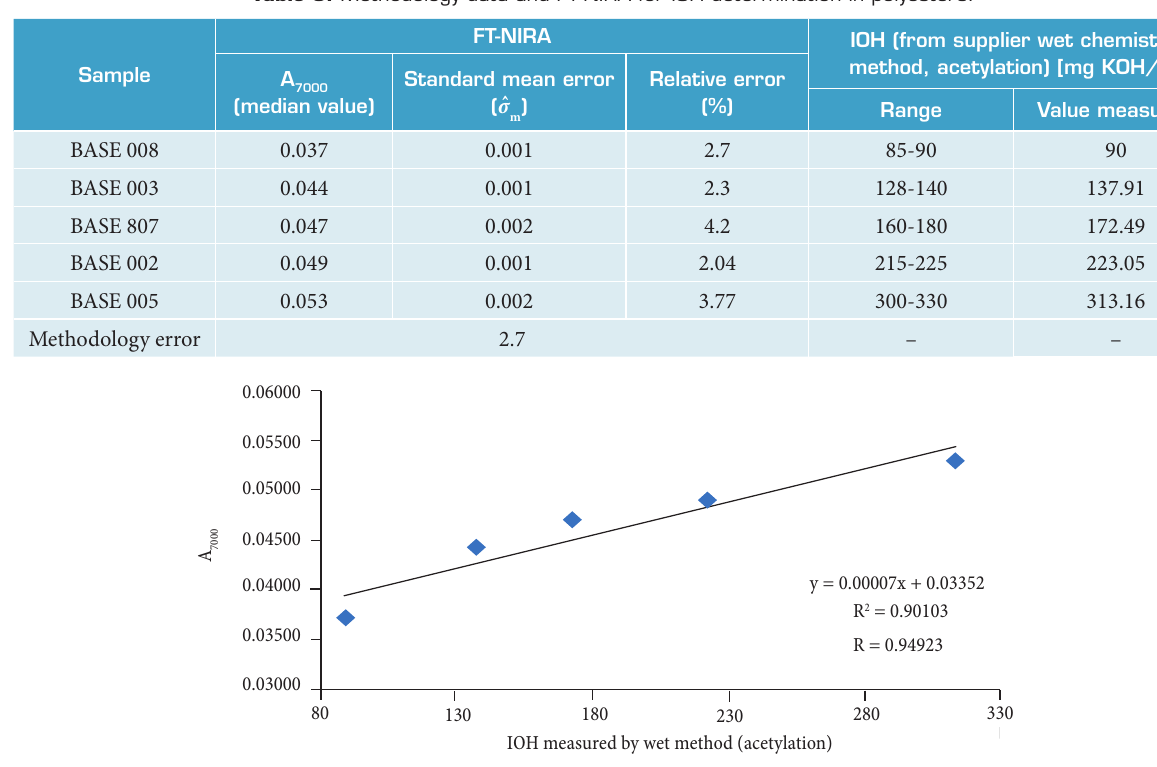
Figure 13. FT-IR/NIRA calibration curve of A